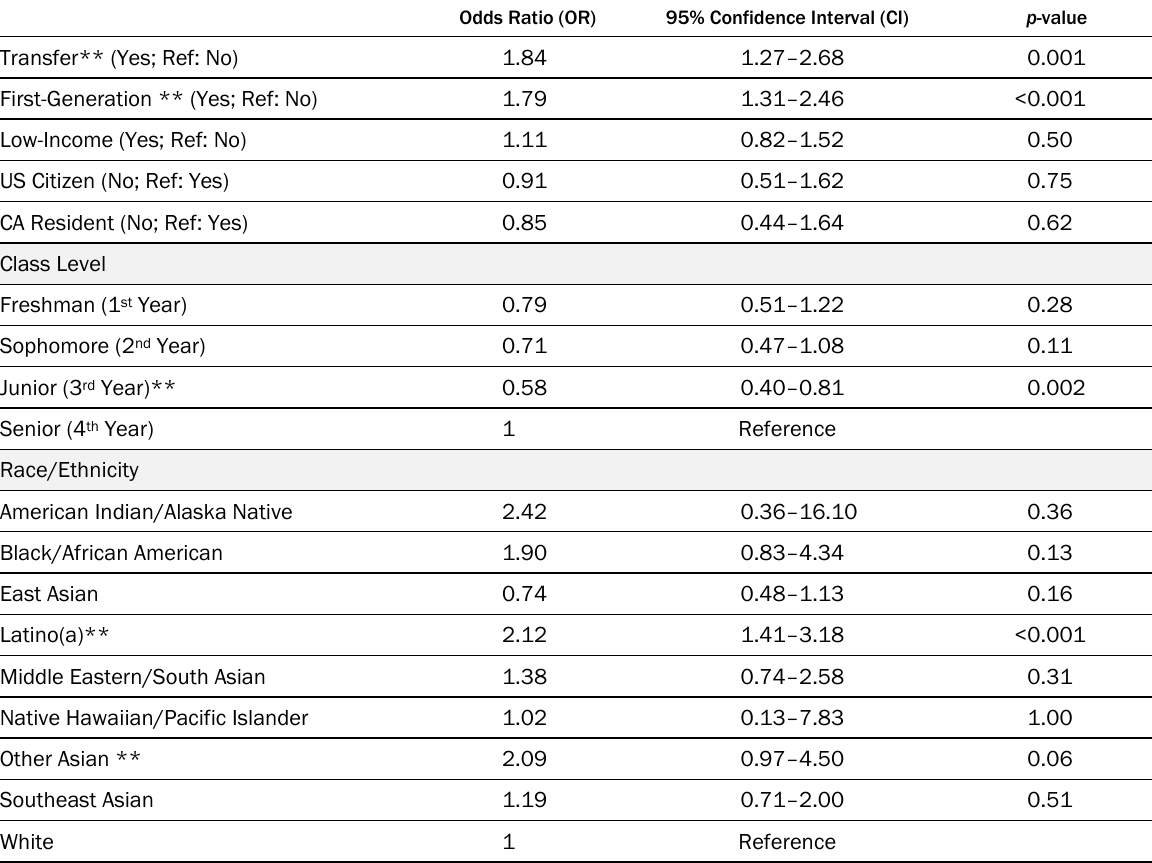
Table 3. Student Characteristics’ Associations with Food Insecurity Using Logistic Regression Odds Ratio (OR) 95% Confidence Interval